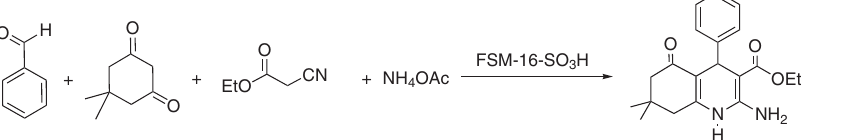
Scheme 2: Synthesis of polyhydroquinolines using a one-pot, four-component reaction in the presence of FSM-16-SO